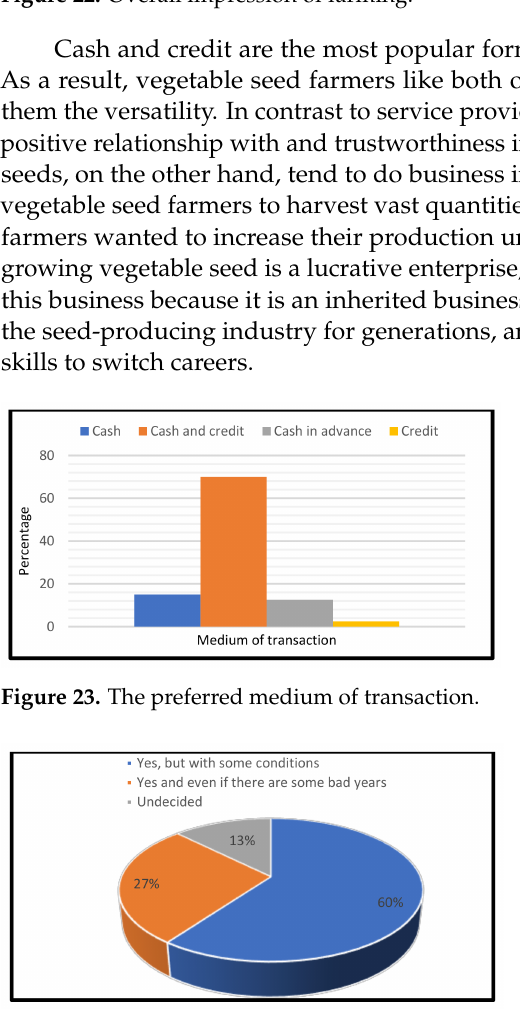
Figure 22. Overall impression of farming.